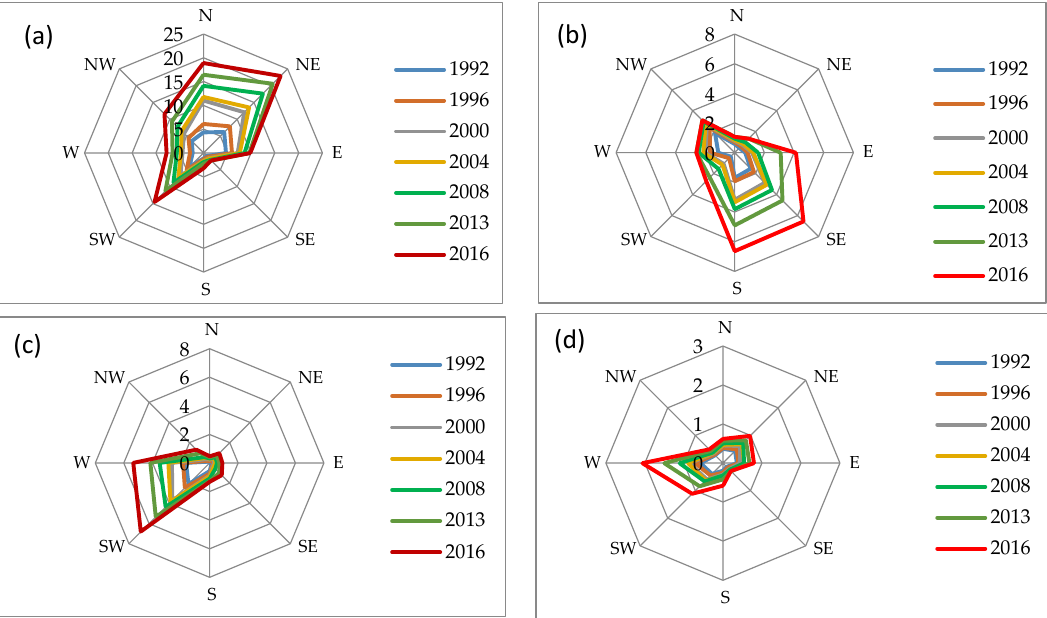
Figure 7. Urban orientation map-1992-2016 (excluded 1988): ( a ) Kathmandu; ( b ) Lalitpur; ( c ) Bhaktapur; and ( d ) Kabhrepalanchok.